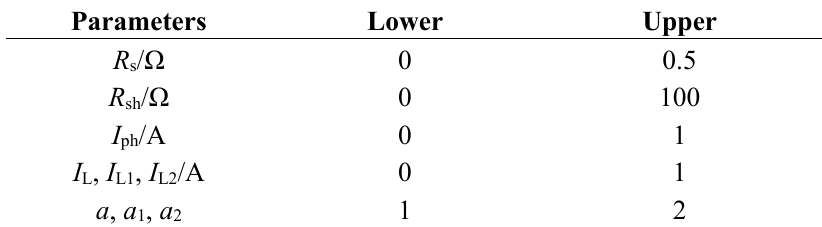
Table 5. Upper and lower range of the solar cell